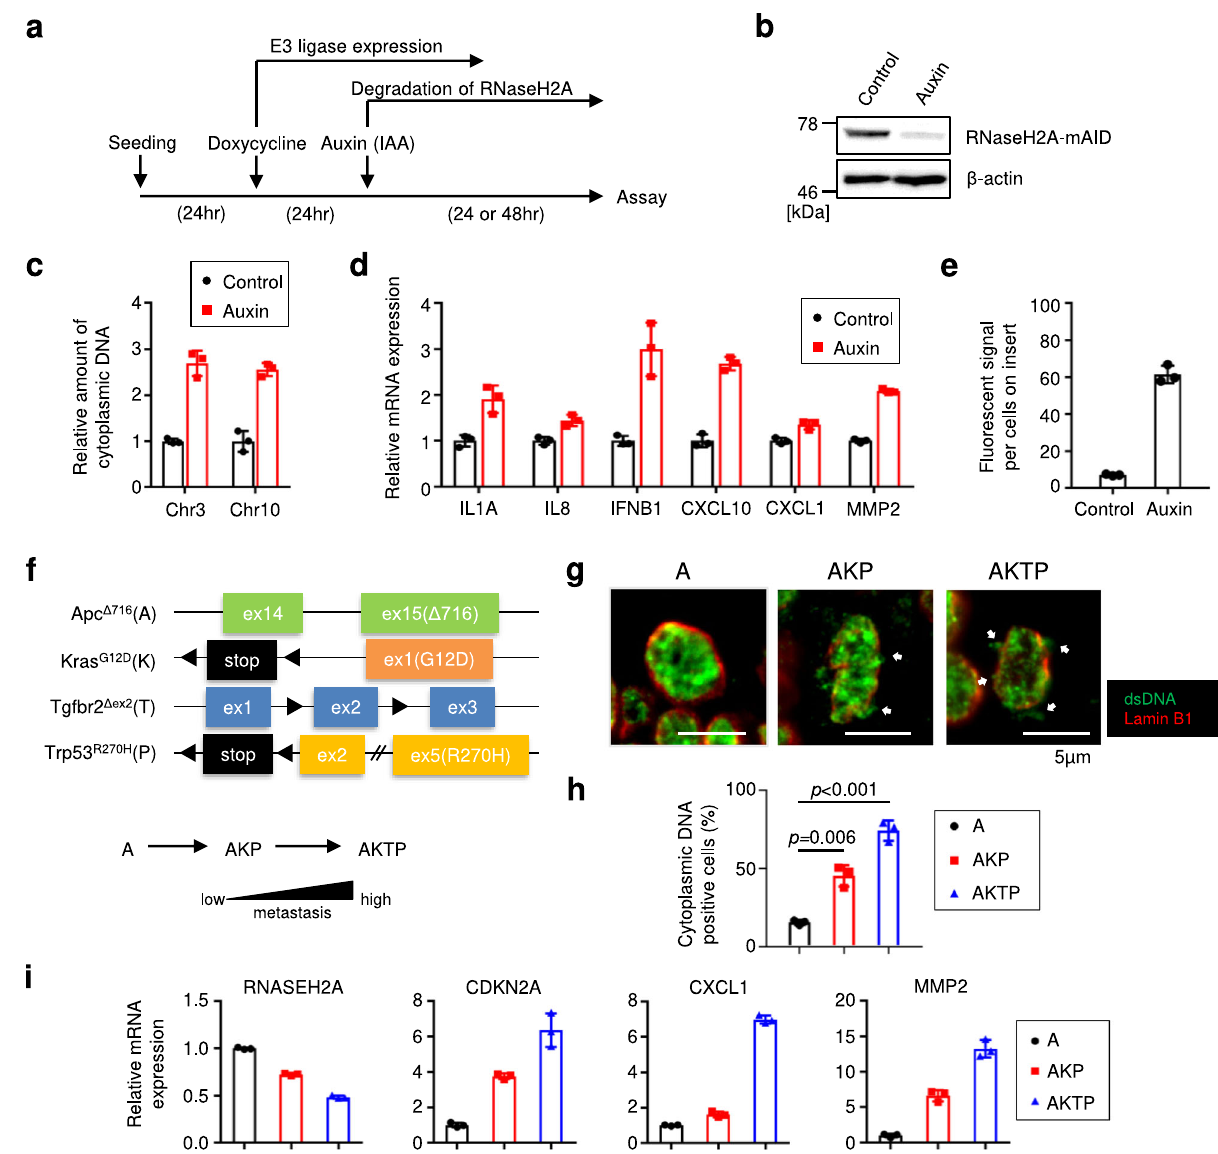
Fig. 7 RNaseH2A depletion leads to malignant transformation in cancer cells. a Scheme of experiments with HCT116 cells stably expressing TIR1 and RNaseH2A-mAID. Cells were treated with 500 μ M auxin to degrade RNaseH2A-mAID for 24 h ( b , c , e ) or 48 h ( d ). b Western blot of HCT116 cells as in a using antibodies shown at right. Beta-actin was used as a loading control. c Quantitative PCR analysis of chromosomal DNA in the cytoplasm from HCT116 cells as in a using primers against chromosomes 3 and 10. Error bars indicate the mean ± SD of technical triplicates. d RT-qPCR analysis of the indicated genes was conducted using RNA extracted from HCT116 cells as in a . Error bars indicate the mean ± SD of technical triplicates. e Cell invasion assay using HCT116 cells as in a . Error bars indicate the mean ± SD of technical triplicates. f Top: Schematic representation of mutant alleles of each driver gene. Bottom: Schematic representation model of the evolutionary changes in the gene expression pattern in association with malignant progression phenotypes. g Colon cancer organoids were subjected to immuno fl uorescence for indicated antibodies. Scale bars indicate 5 µ m. White arrows show dsDNA fragments in the cytoplasm. h The percentage of cytoplasmic DNA-positive cells in g . Error bars indicate the mean ± SD of biological triplicates. One-way ANOVA coupled with Dunnett ’ s multiple comparisons test. i RT-qPCR analysis of the indicated genes was performed using RNA extracted from colon cancer organoids as in g . Error bars indicate the mean ± SD of technical triplicates. All data were representative of at least three biological